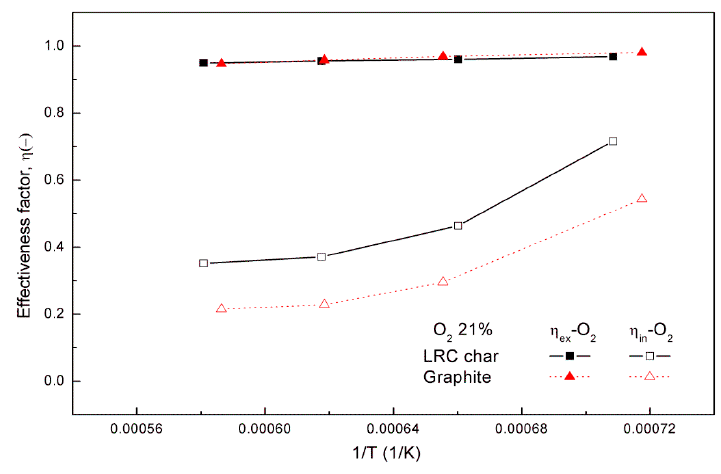
Figure 8. Effectiveness factors as a function of particle temperature at an ambient oxygen concentration of 21%.